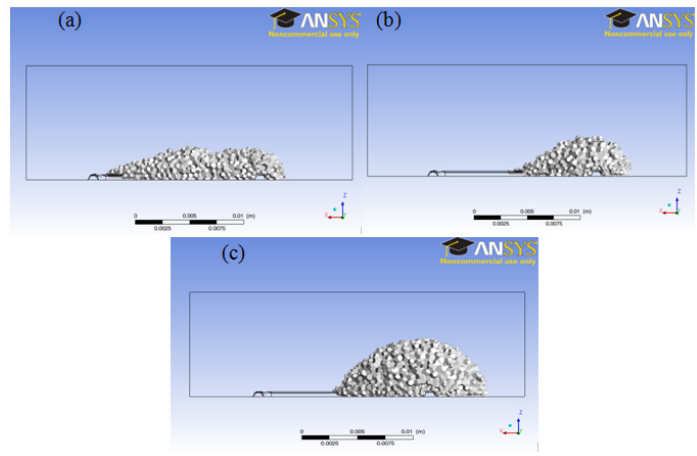
Figure 50. Cavity shape for cases with different initial permeabilities: ( a ) 1 mD, ( b ) 100 mD, and ( c ) 10 D (reproduced from Shirazi et al. [50]).